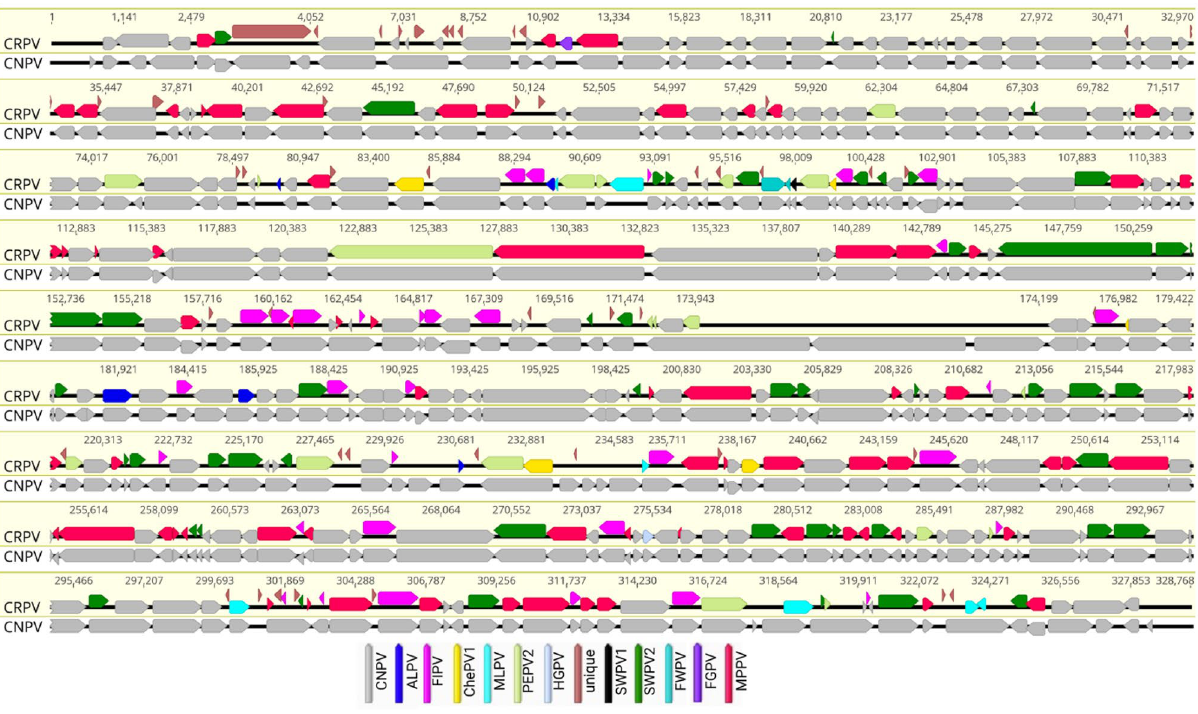
Figure 1. Genomic illustration of CRPV in comparison with CNPV was visualised using Geneious Prime ® (version 2022.1.1). The arrows depict the direction of transcription of genes and open reading frames (ORFs). Each ORF of CRPV genome is colour coded based on homology to other avipoxviruses, as indicated by the key in the